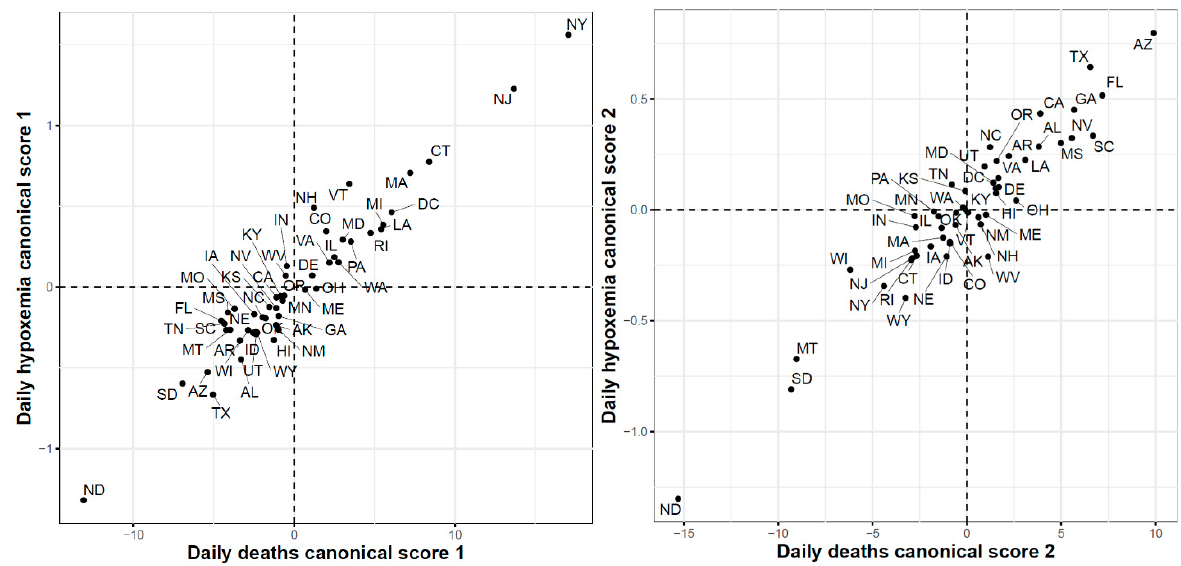
Figure 18. First ( left ) and second ( right ) functional canonical variables scores of the COVID-19 deaths versus. the Google daily searches for hypoxemia.